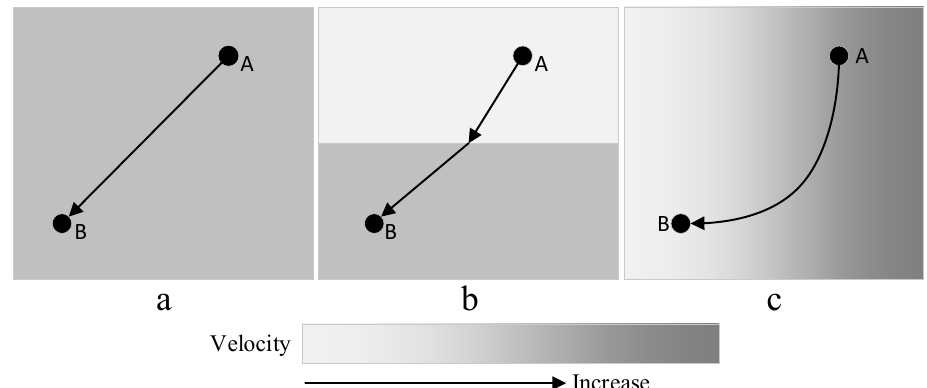
Figure 1. Ray path from point A to B in different velocity models, ( a ) Uniform velocity model; ( b ) Layered velocity model; ( c ) Continuously changing velocity model.